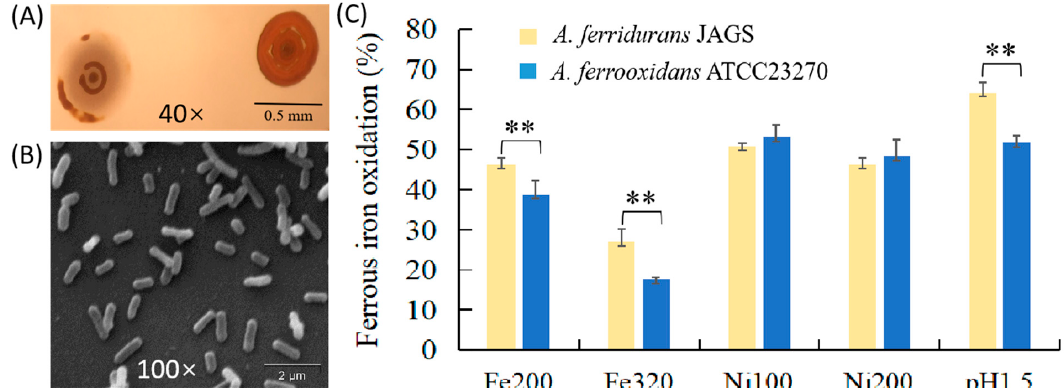
Figure 1. Differentiation of Acidithiobacillus ferridurans JAGS from closely related species. ( A ) Colony morphologies of A. ferridurans JAGS observed under 40 × optical microscopy for both top and bottom images. ( B ) Cell morphology observed under SEM. ( C ) Ferrous iron oxidation rates of A. ferridurans JAGS and A. ferrooxidans ATCC23270 under different pressures of Fe200 (200 mM Fe 2+ ), Fe320 (320 mM Fe 2+ ), Ni100 (100 mM Ni 2+ ), Ni200 (200 mM Ni 2+ ) and pH 1.5. ** indicates p < 0.01.